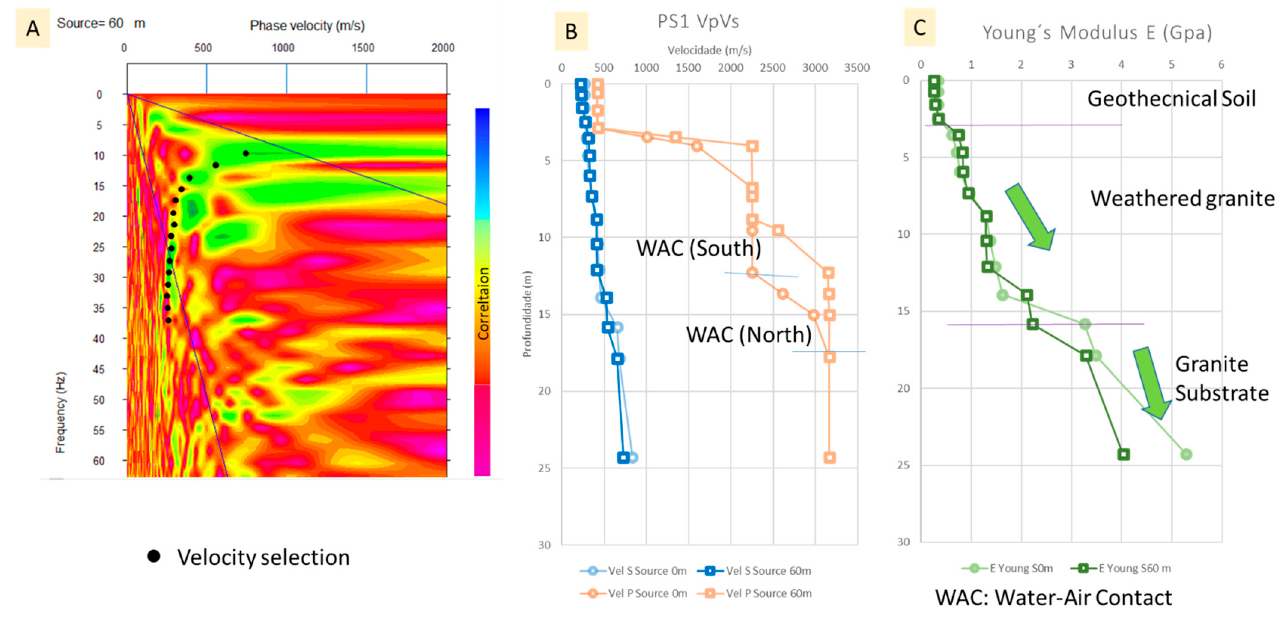
Figure 7. MASW results analysis in the PS1 profile (shots at 0m and 60 m): ( A ) Apparent velocity spectra and fundamental mode velocity selection (shot at 60 m); ( B ) P-wave (from seismic refraction) and S-wave (MASW) velocity curves; ( C ) Young’s modulus “E” curves and its geomechanical inter- pretation.